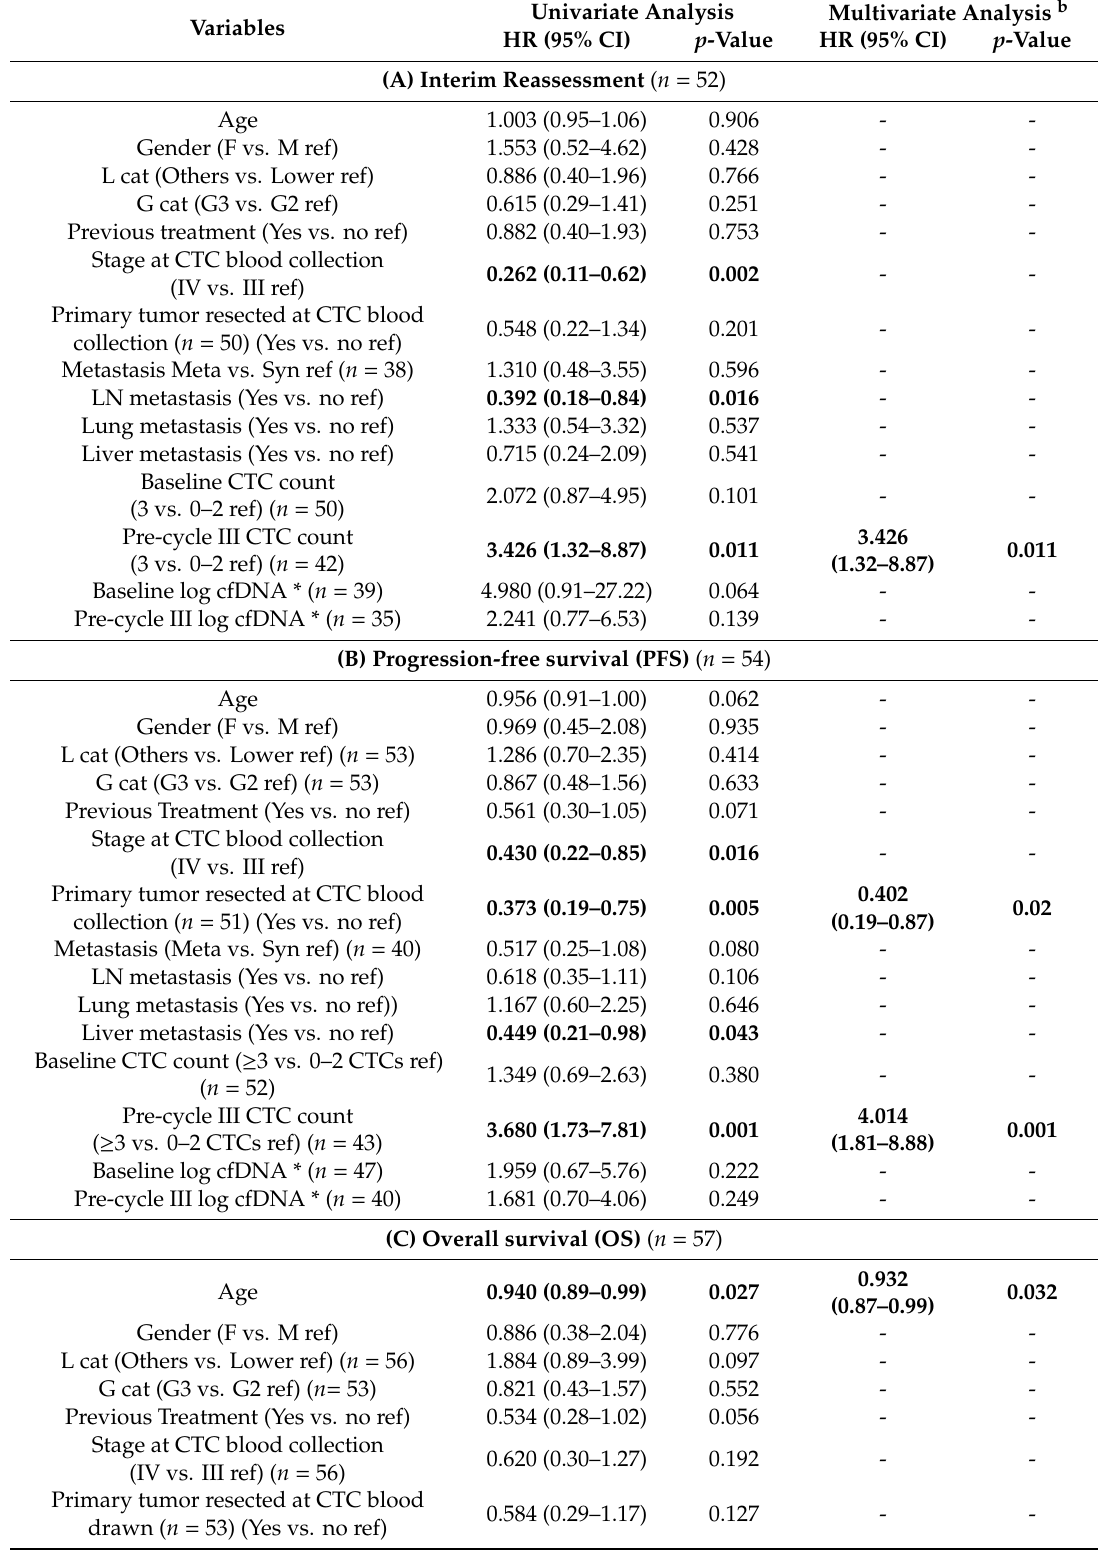
Table 2. Univariate and multivariate COX regression analysis of clinical parameters, CTC counts and cfDNA levels at baseline and two cycles of chemotherapy (Pre-cycle III) with interim imaging reassessment, progression-free and overall